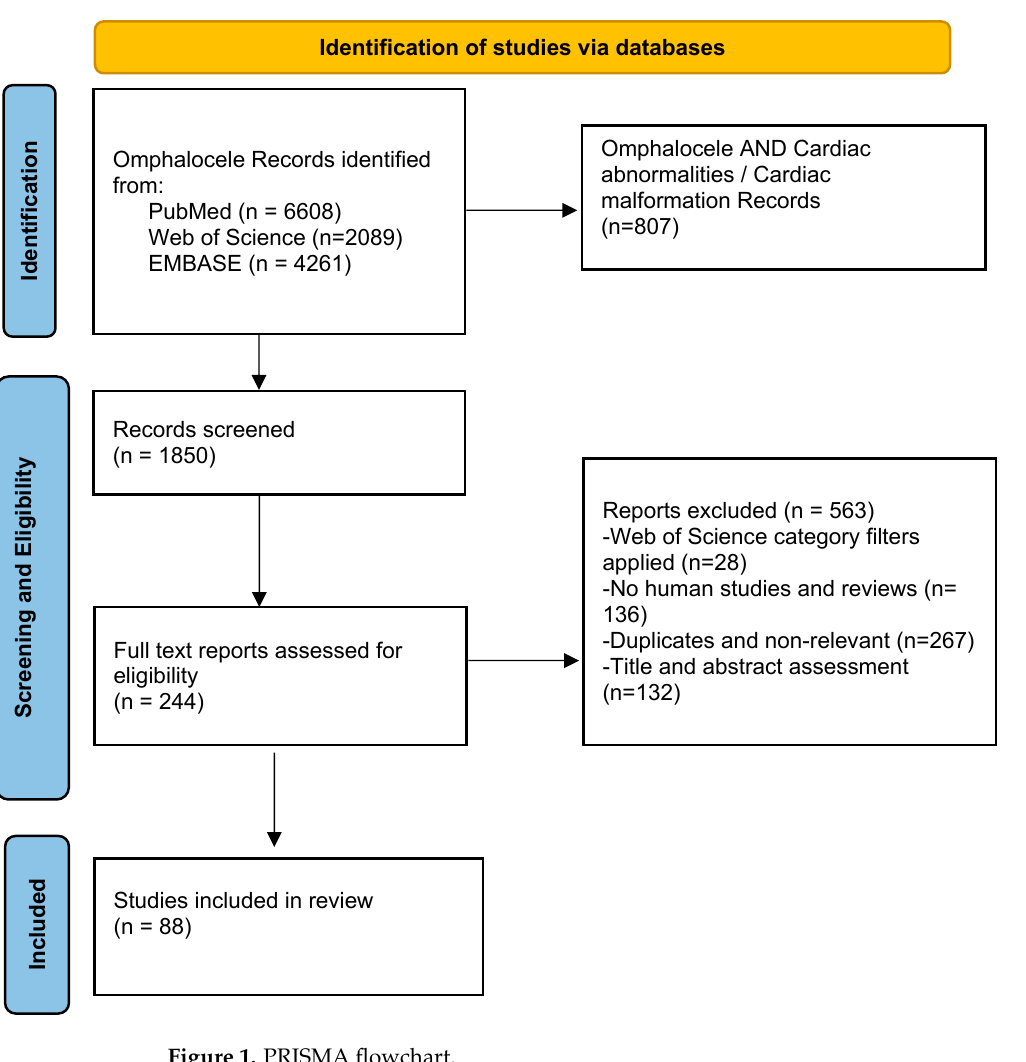
Figure 1. PRISMA flowchart